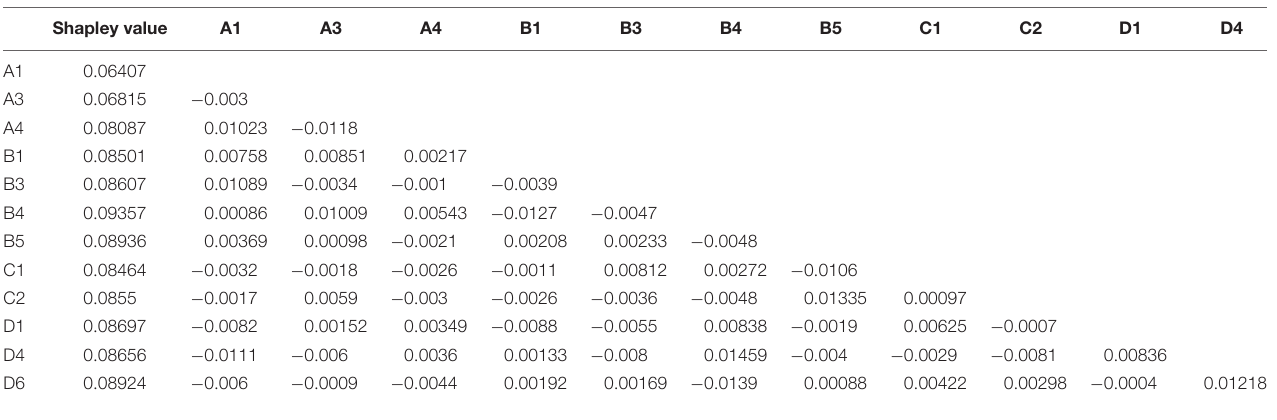
TABLE 6 | The Shapley value and interaction indexes of sub-criteria. Shapley